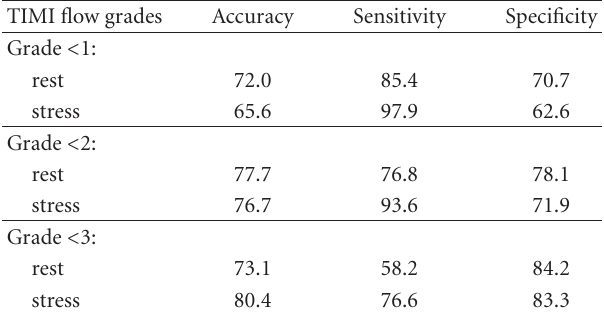
Table 5: Accuracy, sensitivity, and specificity of abnormal in MCE Visual Interpretation at rest and stress with di ff erent TIMI flow grades as abnormal (%).